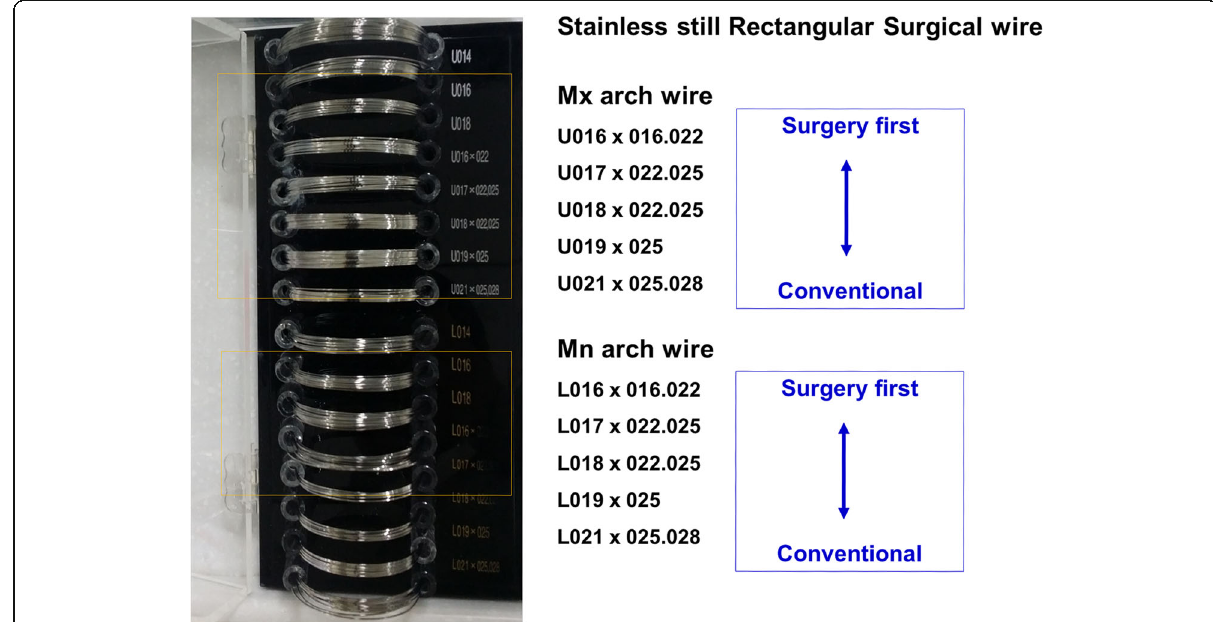
Fig. 7 An example of suggestions for the use of surgical archwires for surgery-first and conventional approaches for orthognathic surgery